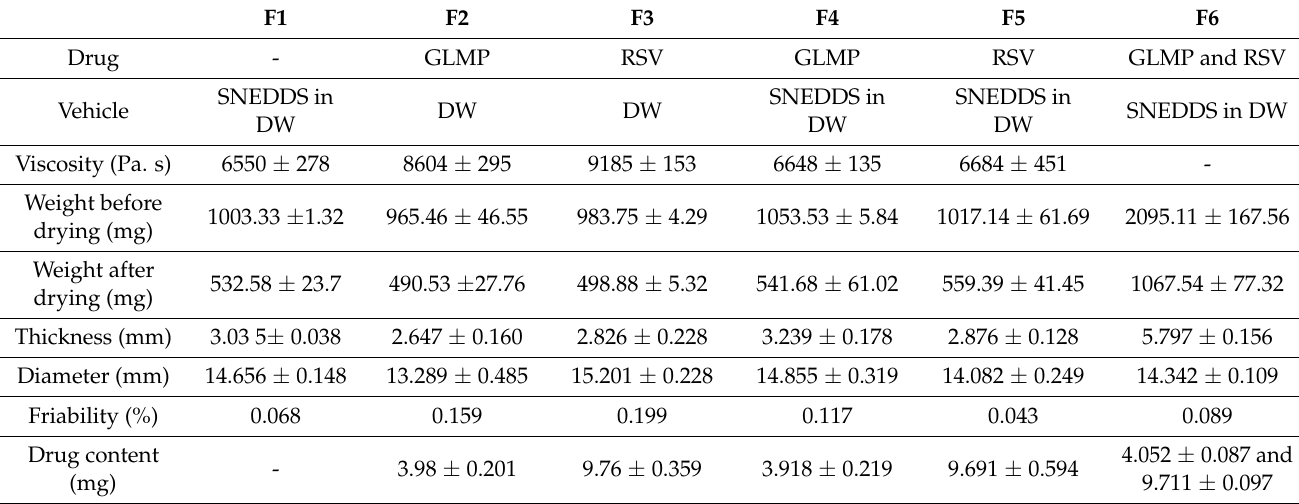
Table 2. Composition and characteristics of the prepared pastes and the 3DP